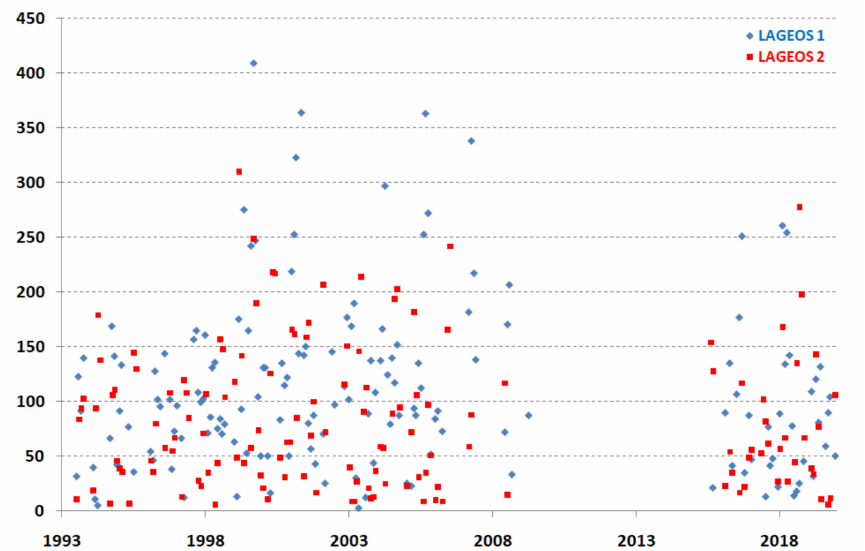
Figure 2. Borowiec SLR station—the number of normal points for the satellites LAGEOS-1 and LAGEOS-2 (monthly data).